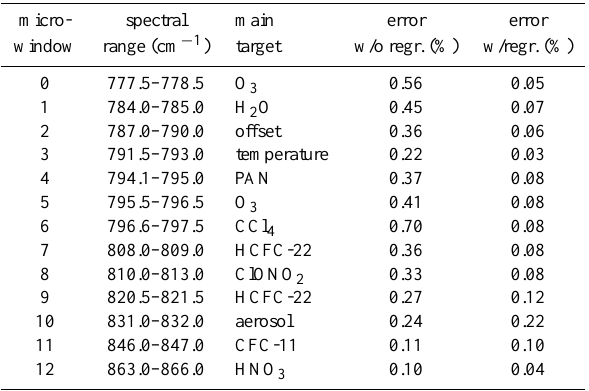
Table 1. Microwindows used in the retrieval including main targets. The last two columns give the standard deviation of relative error of our forward model compared to RFM with and without